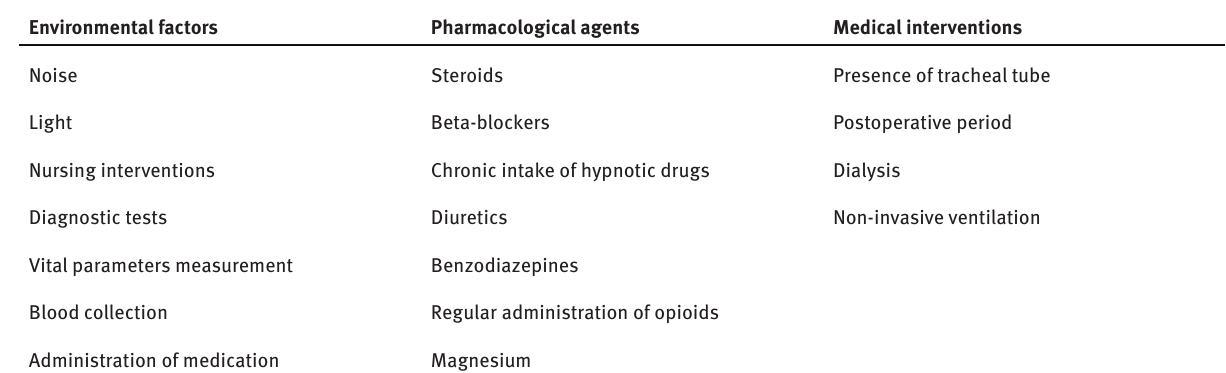
Table 2: Sleep disturbing factors in ICU patients [25].